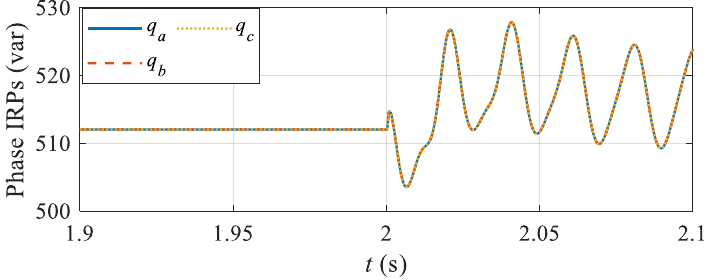
Figure 7. The phase IRPs before and after ITSC, without neutral conductor. Operating conditions: machine speed ω m = 300 r/min and load torque T L = 10 N∙m. Fault severity: Δ = 0.01, r f = 50 mΩ.